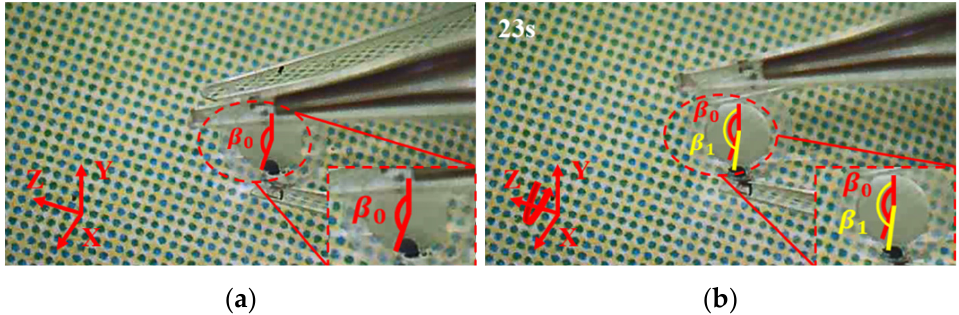
Figure 23. The zebrafish embryo is rotated about axis Z. ( a ) the zebrafish embryo is moved to a distance; ( b ) the zebrafish embryo is rotated about axis Z.